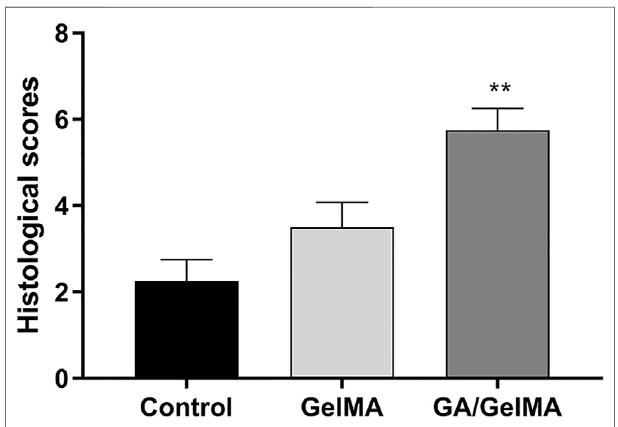
FIGURE 8 | Histological evaluation score. GA/GelMA group had a signi fi cant increase in the histological evaluation score. Data are expressed as means ± SD. * p < 0.05 and ** p < 0.01 between two groups.